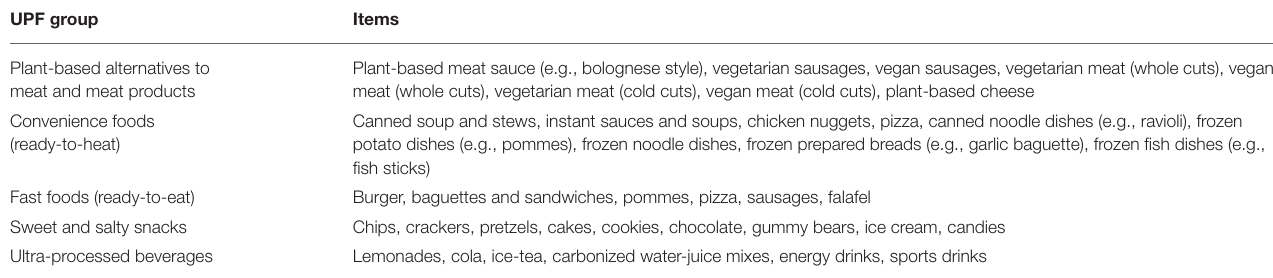
TABLE 2 | Classification of ultra-processed foods. UPF group Items Plant-based alternatives to meat and meat